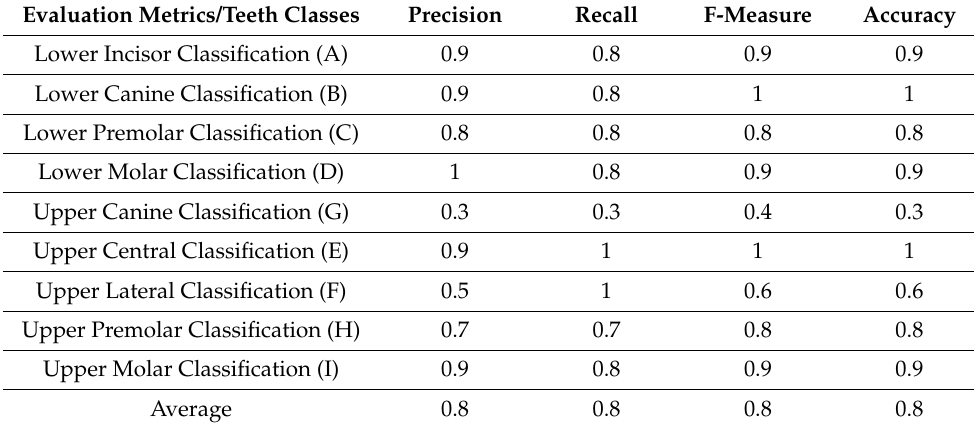
Table A1. Classifier evaluation metrics: Precision, Recall, F-measure and overall accuracy for each Featured